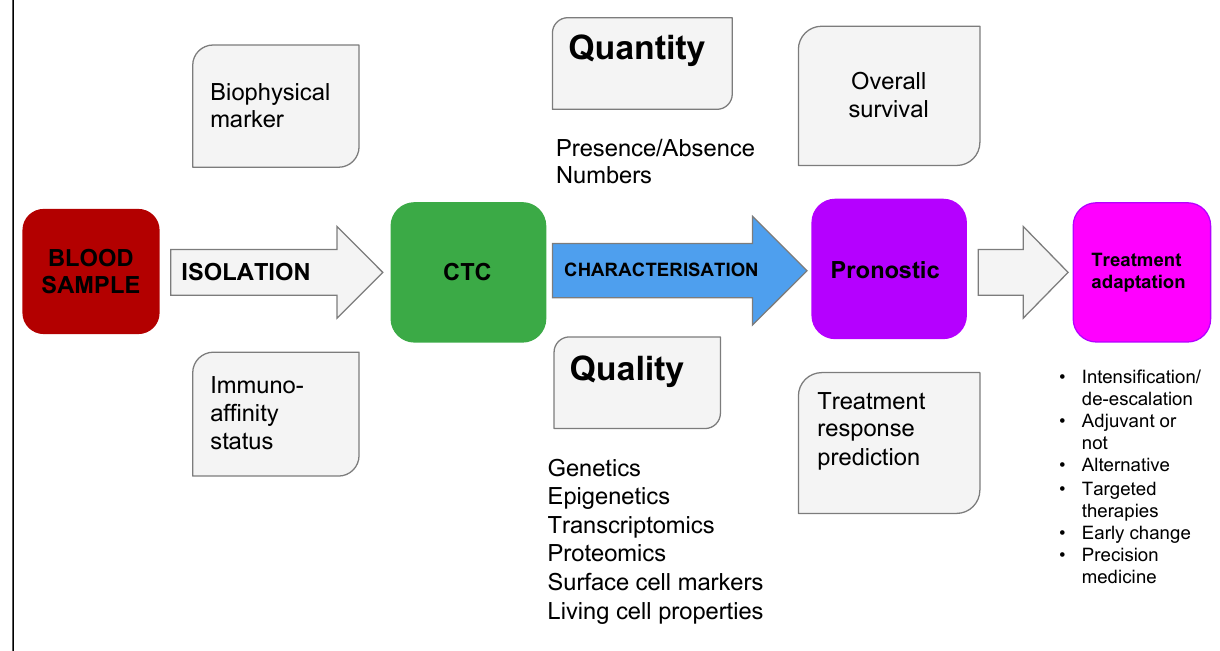
Figure 1. Colorectal cancer (CRC) circulating tumour cells (CTCs), from blood sample to clinical application.